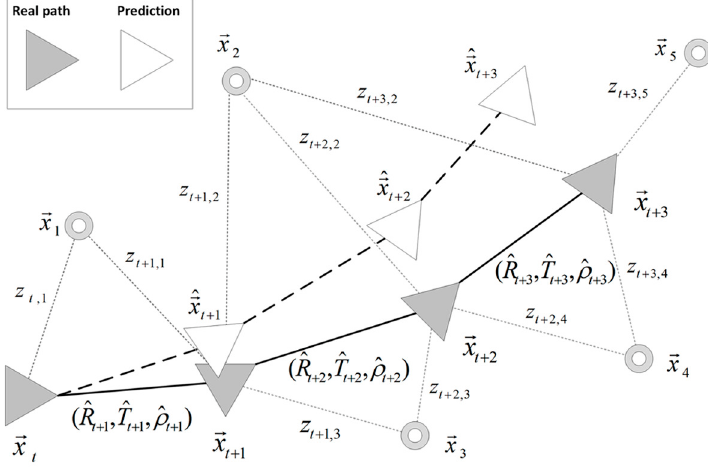
Figure 8. Graph diagram of a robot trajectory. Real path poses, (cid:126) x t , and predicted poses, ˆ (cid:126) x t , at each t are indicated, following the notation described in Equations (13) and (14). Observation measurements, z t , n , and views in the environment, (cid:126) x n , are also